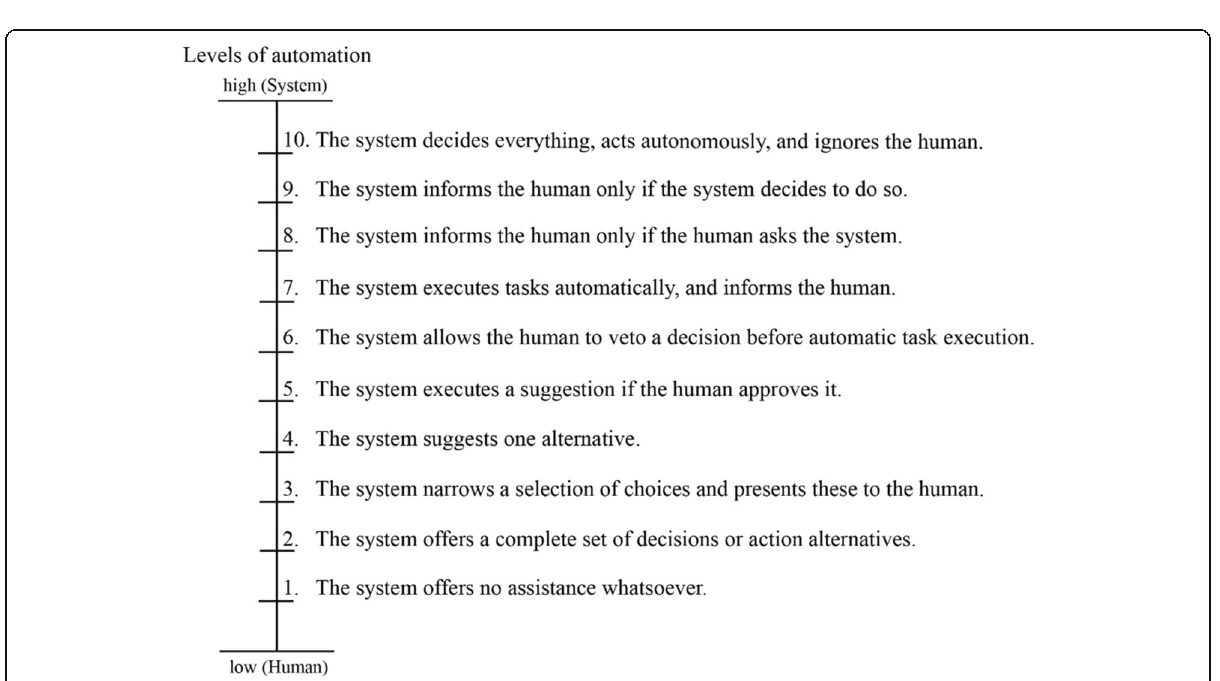
Fig. 1 Levels of automation of decision and action selection (original figure in Parasuraman et al., 2000; adjusted text and extended with a linear scale): either the system decides and performs actions (high level of automation = System), or the human decides and performs actions (low level of automation =